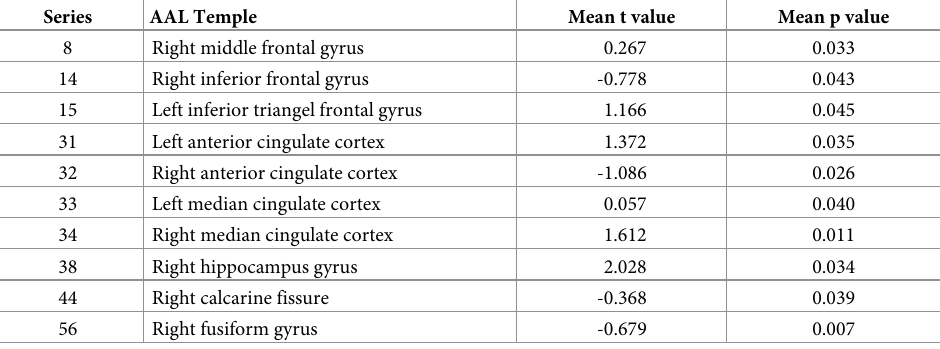
Table 3. Brain regions with significant group differences in local clustering coefficient between the CCH and con- trol groups (corrected p < .05).